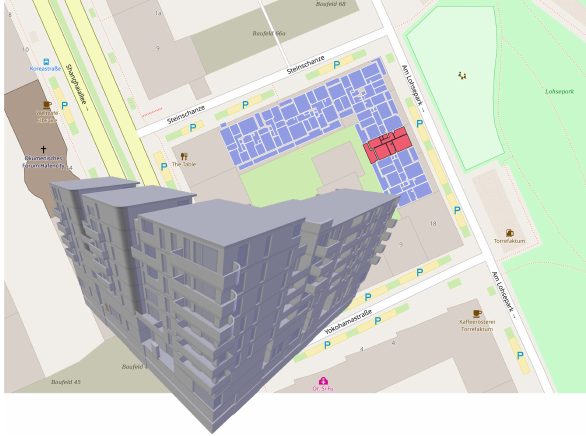
Figure 3. In this practical example, the floor plan of residential buildings (BIM) is shown on the map. This software feature would have been much easier to achieve with better BIM / GIS standards. Figure from (Clemen and Roxin, 2020)